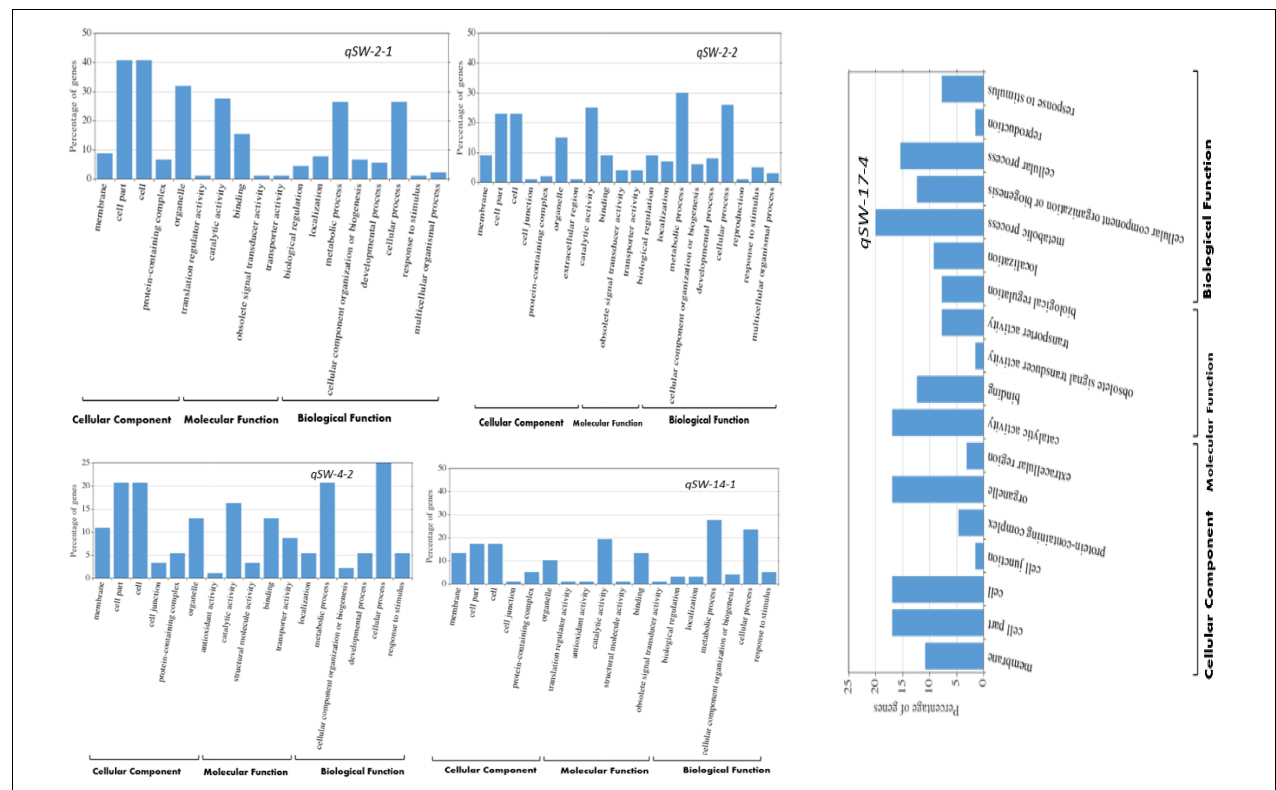
FIGURE 4 | WeGO analysis of the genes located within the stable QTL regions viz., qSW-2-1 , qSW-2-2 , qSW-4-2 , qSW-14-1 , and qSW-17-4 .